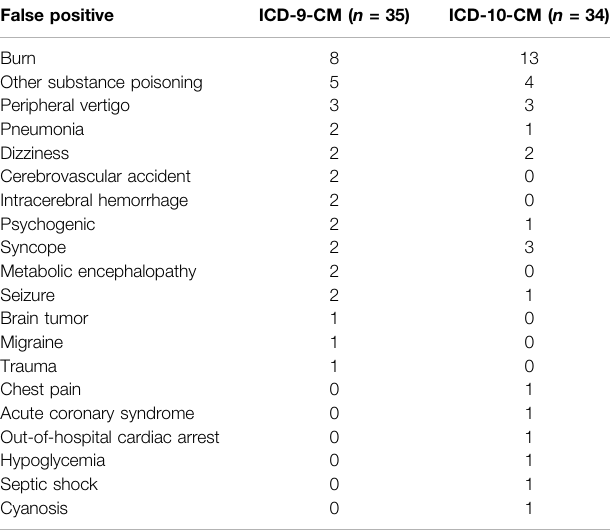
TABLE 2 | Reasons for false-positive carbon monoxide poisoning